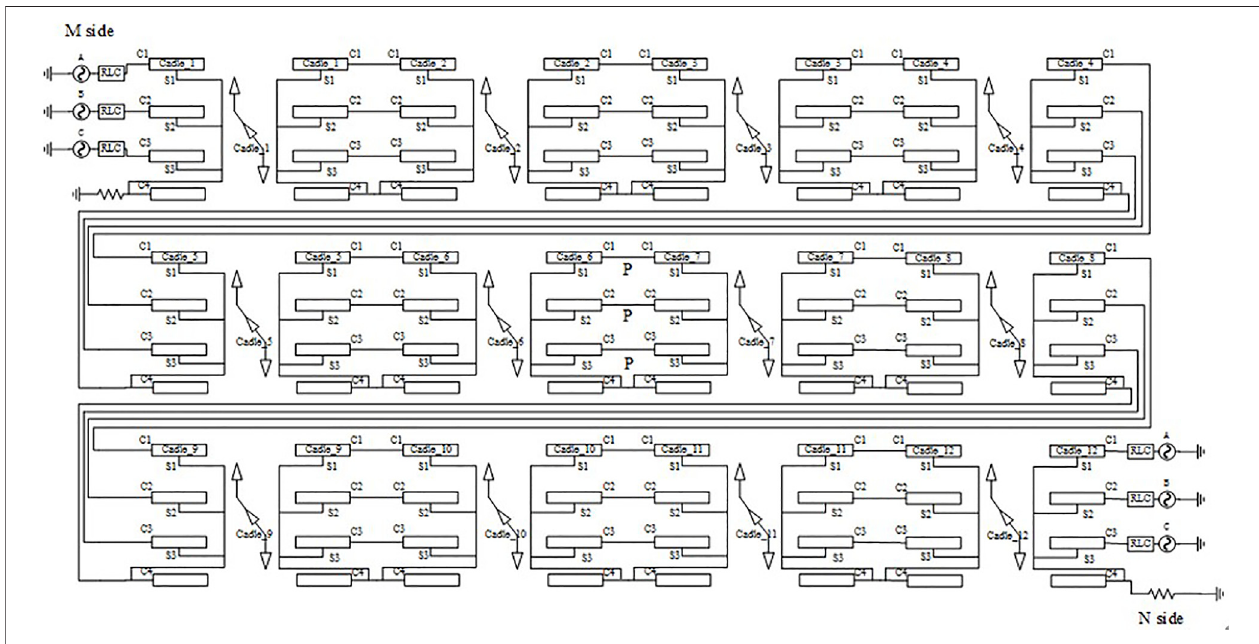
FIGURE 5 | Schematic diagram of the GIL simulation model.